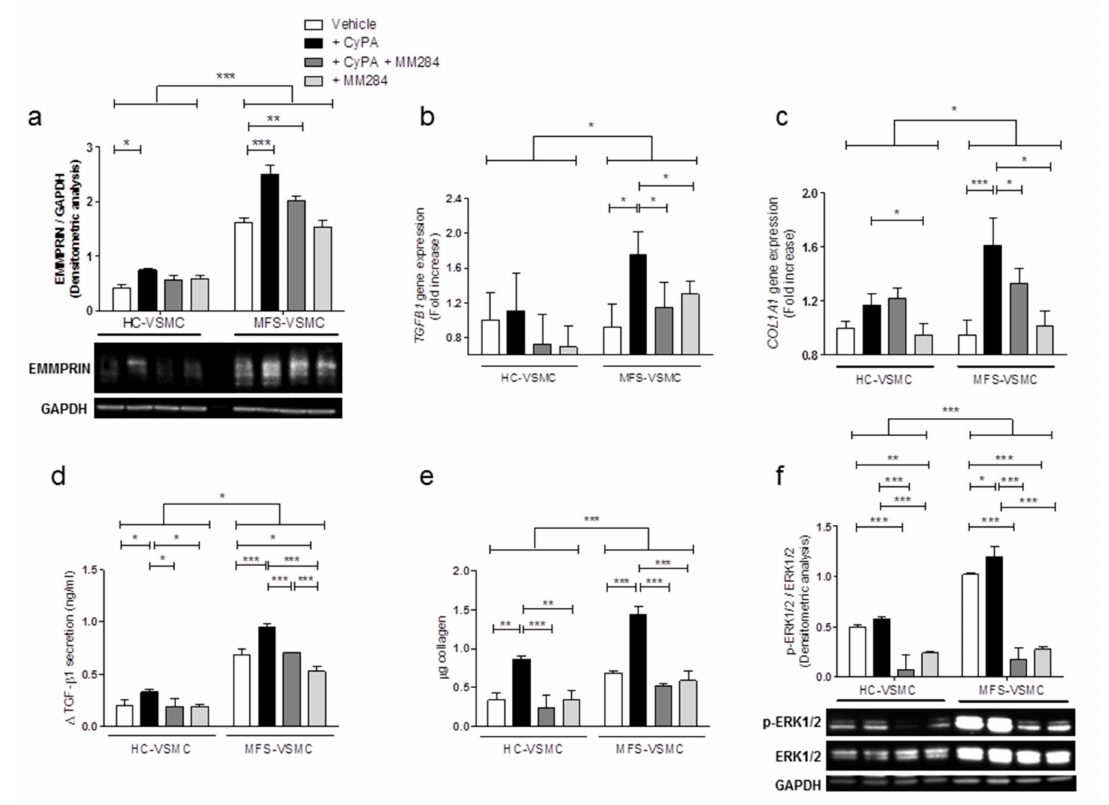
Figure 6. CyPA treatment activates ERK1 / 2 pathway in MFS-VSMC and promotes pro-fibrotic gene upregulation. ( a ) EMMPRIN expression levels in HC-VSMC and MFS-VSMC, after 100 ng / mL CyPA, 250ng / mL MM284, and treatment with both molecules. Protein quantification data are shown as mean ± SD, n = 5. GAPDH has been used as loading control. Two-way ANOVA and Bonferroni’s post-test: * p < 0.05, ** p < 0.01, *** p < 0.0001. ( b , c ) TGFB1 ( b ) and COL1A1 ( c ) gene expression